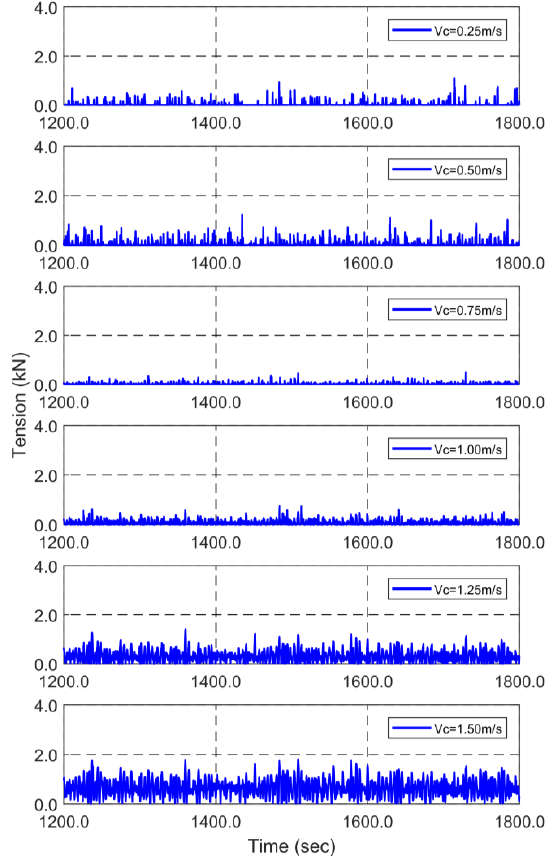
Figure 10. Time histories of rope tension at different current velocities under identical wave excitations ( H s = 1.0 m, T p = 5.25 s). Appl. Sci. 2018 , 8 , x FOR PEER REVIEW